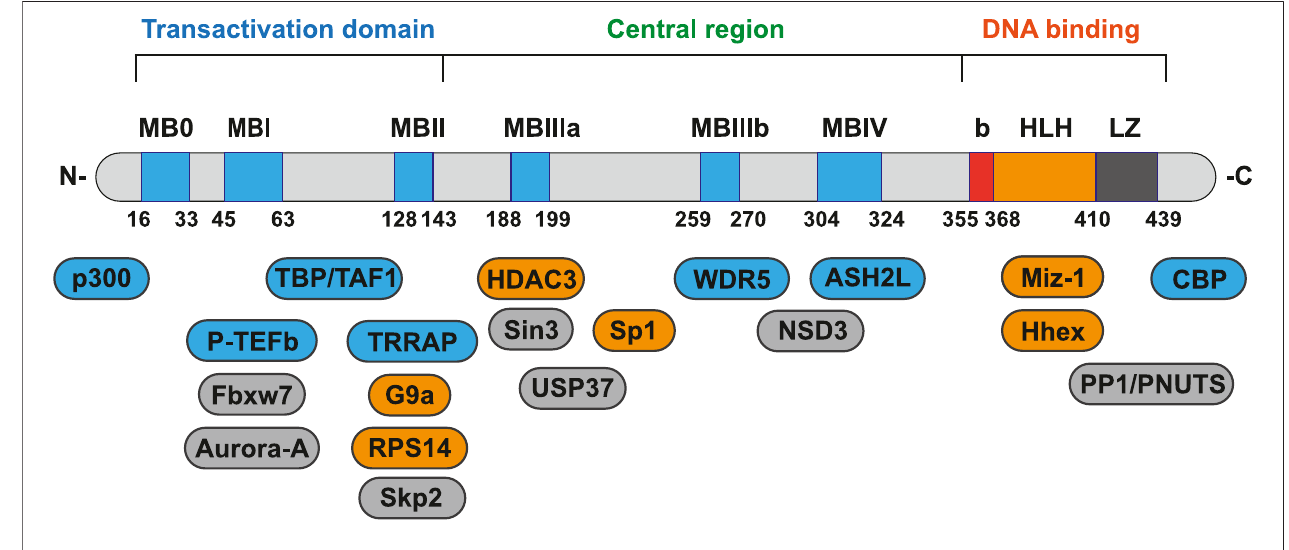
FIGURE 1 | Protein-protein interaction on Myc